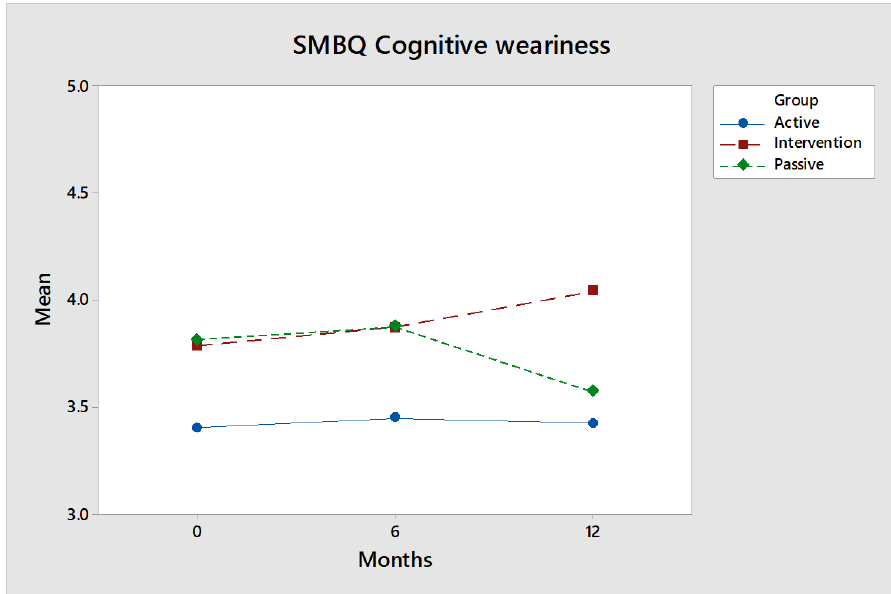
Figure 7. The values regarding SMBQ cognitive weariness for the intervention group (red) increased slightly over time. However, they did not deviate from either baseline or the controls with statistical significance.